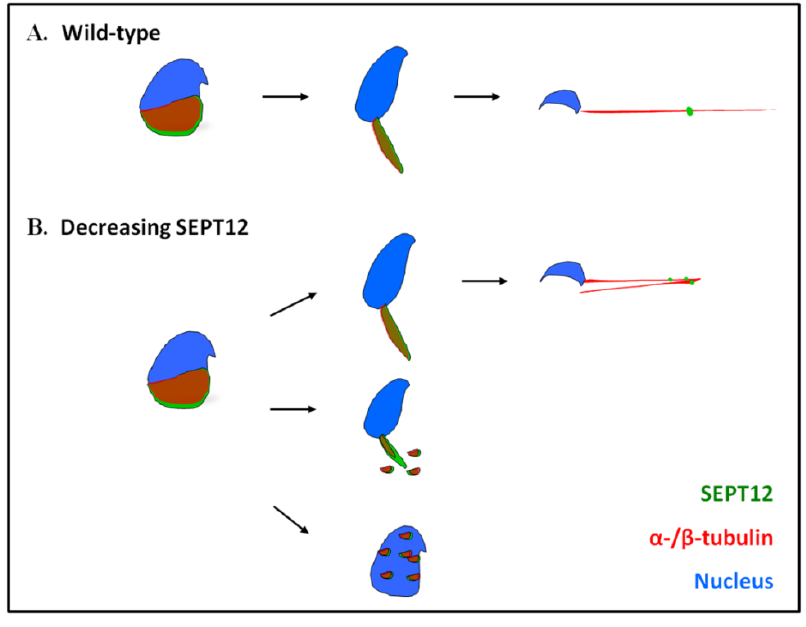
Figure 6. A working model of SEPT12 and α -/ β -tubulins during spermiogenesis. ( A ) In the wild-type spermatozoa, SEPT12 forms the manchette structure of head, which is constituted with α -/ β -tubulins. During sperm elongation, both SEPT12 and α -/ β -tubulins are concentrated at the elongated midpiece to assure its structural integrity and facilitate tail formation. α -/ β -tubulins are the major components of the axoneme of the mature sperm tail; ( B ) By reducing the SEPT12 level, the organization of α -/ β -tubulins is disrupted. For spermatoza that are capable of completing tail elongation, they are presented with defective annulus with tail folded at 180 degrees ( Upper panel). For spermatzoa with severe dysfunction of SEPT12 and α -/ β -tubulins complex, disturbed structure of tail ( middle ) or round head with less tail. Red: α -/ β -tubulins; green: SEPT12; Blue;